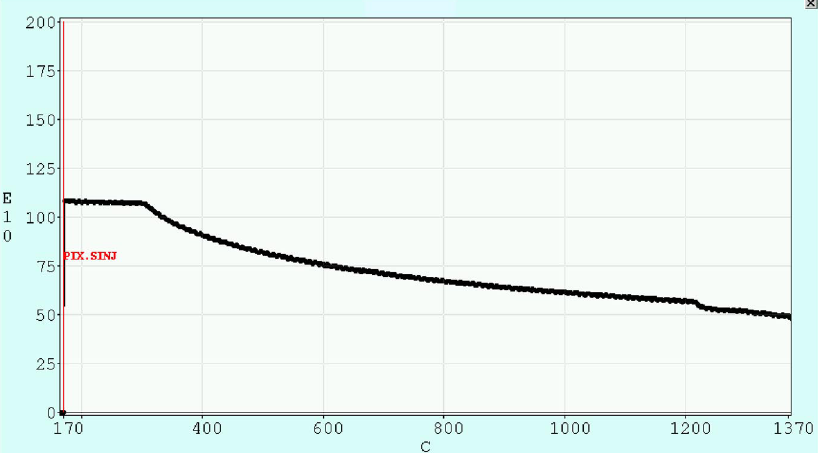
(cid:2) 6 : 27 with octupole powered at 280 ms (110 ms after x